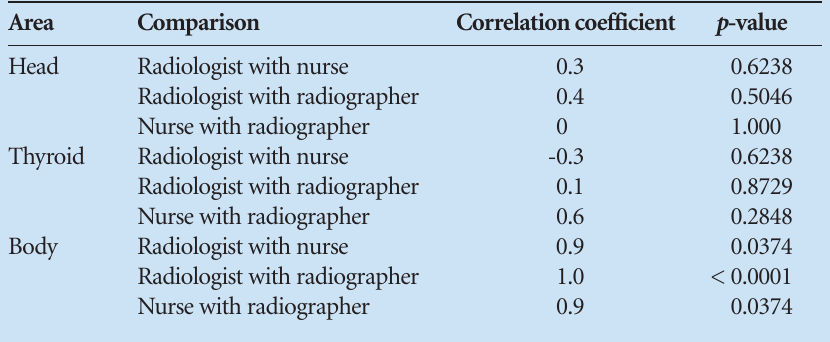
phers and nurses